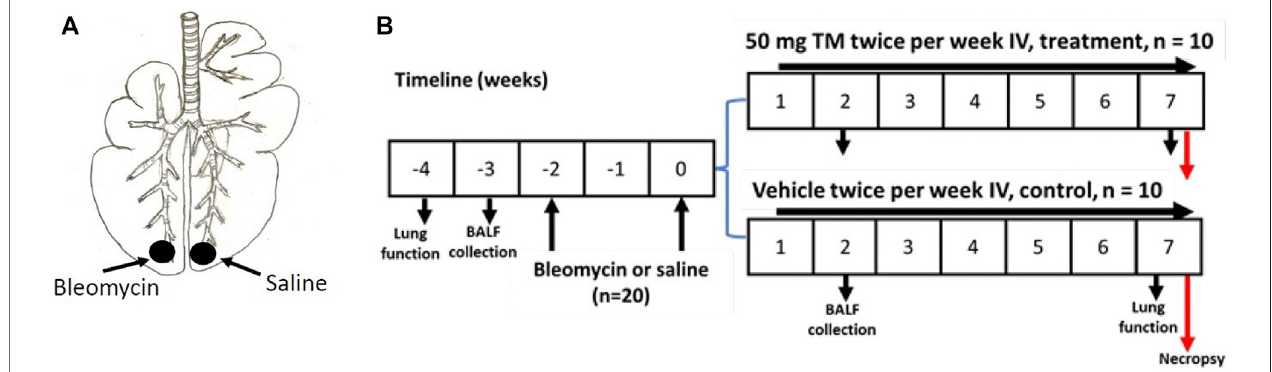
FIGURE1| Inductionofpulmonary fi brosisandadministrationofTMinsheep. (A) Schematicillustrationshowingthebleomycinandsalineinfusionsintothecaudal lung segments of animals. In each animal, while one caudal lung segment was infused with bleomycin, the contralateral segment was infused with sterile saline to act as an internal control. (B) Diagram displaying the timeline for IV treatment of TM, or vehicle (sterile saline), lung function analysis, collection of BAL fl uid, and euthanasia of experimental animals.